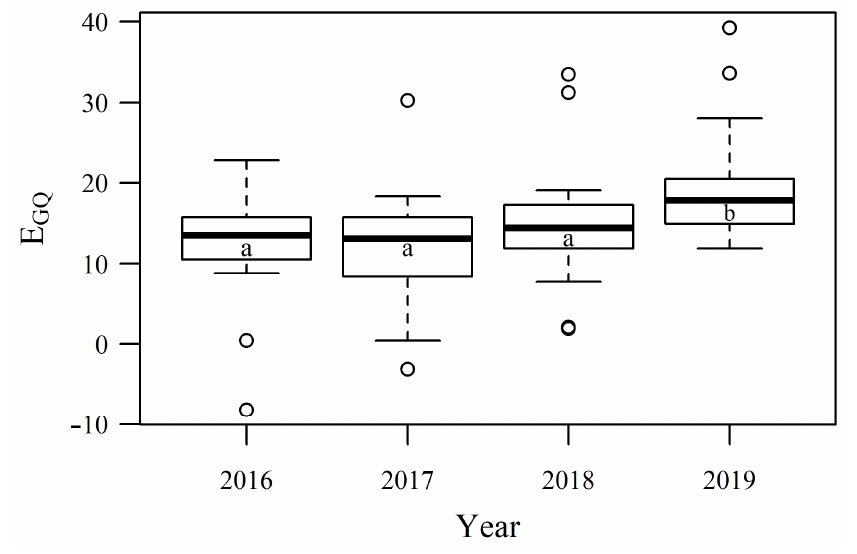
Figure 5. The results of a one-way ANOVA for evaluation of grassland quality ( E GQ ) formula. Different letters indicate significant statistical differences ( p = 0.05 ).